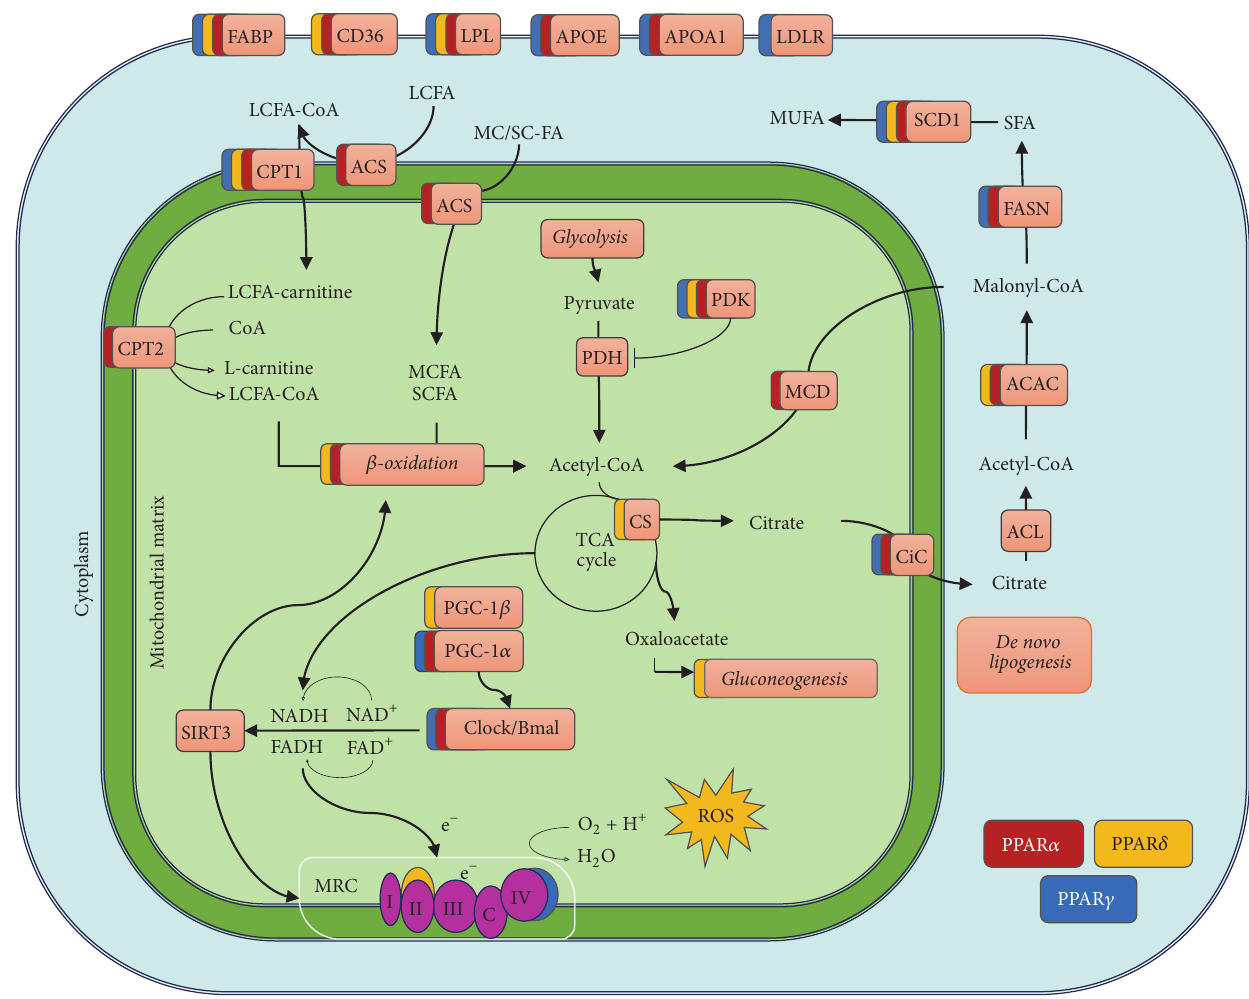
Figure 1: Role of hepatic PPARs in mitochondrial metabolism: fatty acid oxidation, circadian control of NAD+ dependent SIRT activity, de novo lipogenesis, and gluconeogenesis. Color-coding depicts PPAR isotypes-dependency of target